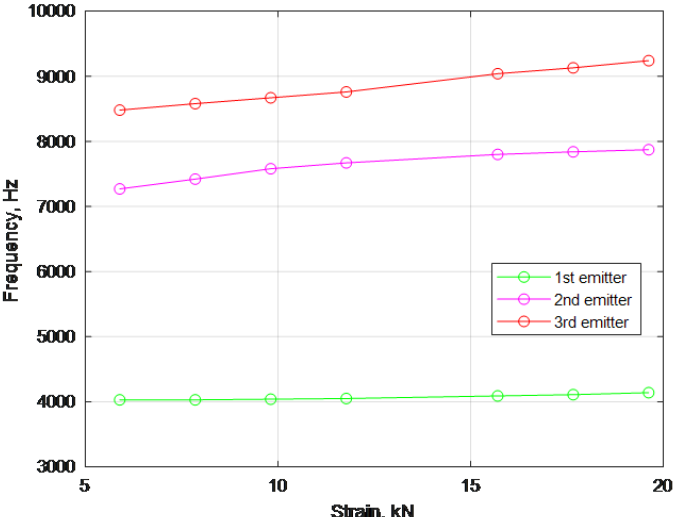
Figure 13. Dependence of the resonance frequency in the function of sample load determined by SAS working with three